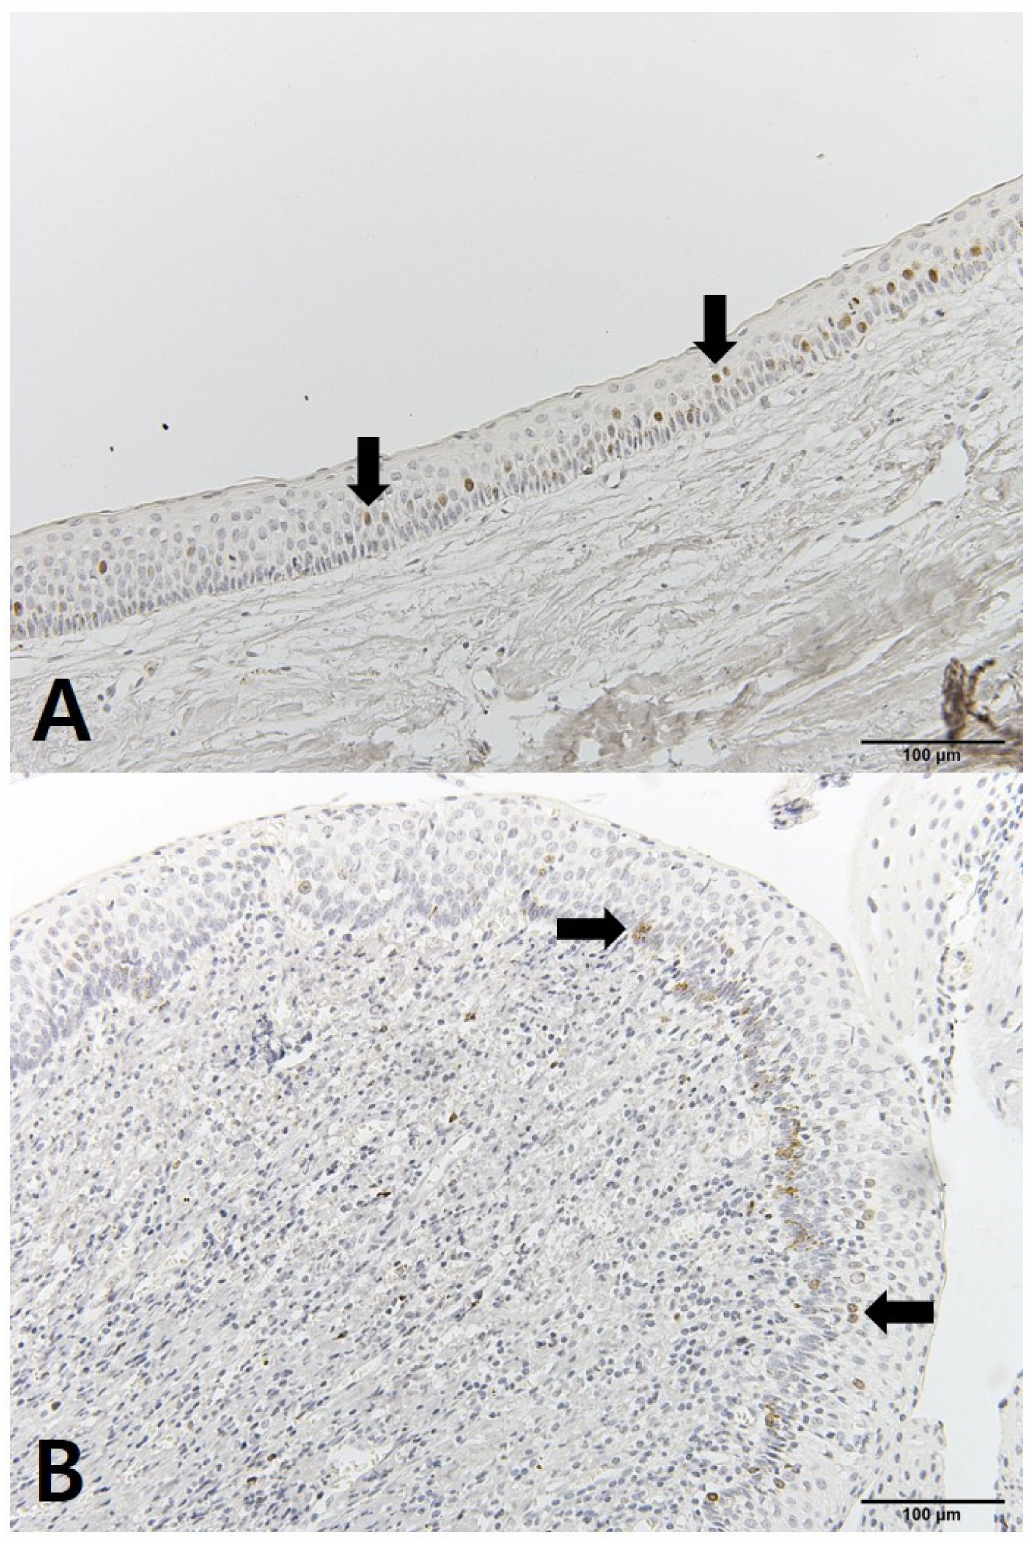
Figure 6. IHC staining of Ki-67: ( A ) tissue obtained at decompression; ( B ) tissue obtained